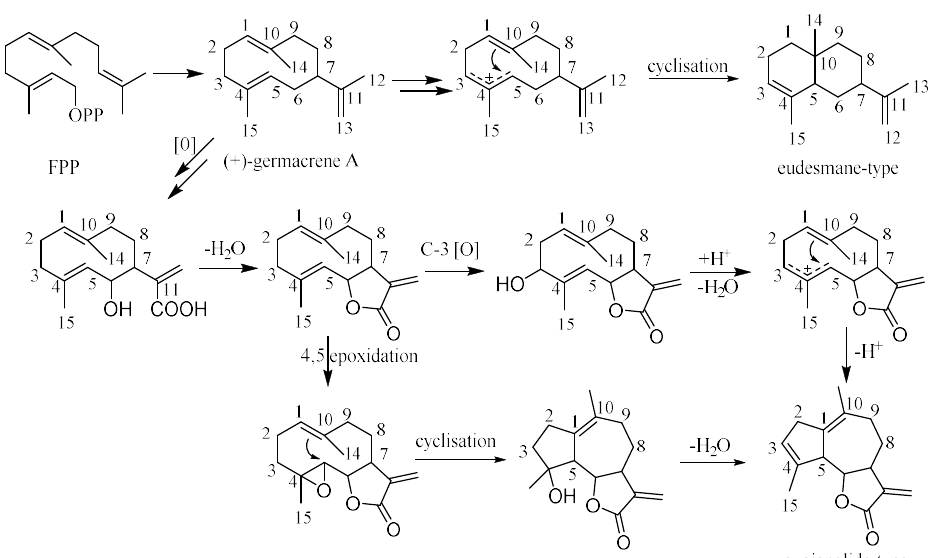
Figure 7. The connection of carbon skeleton of three sesquiterpenoids.